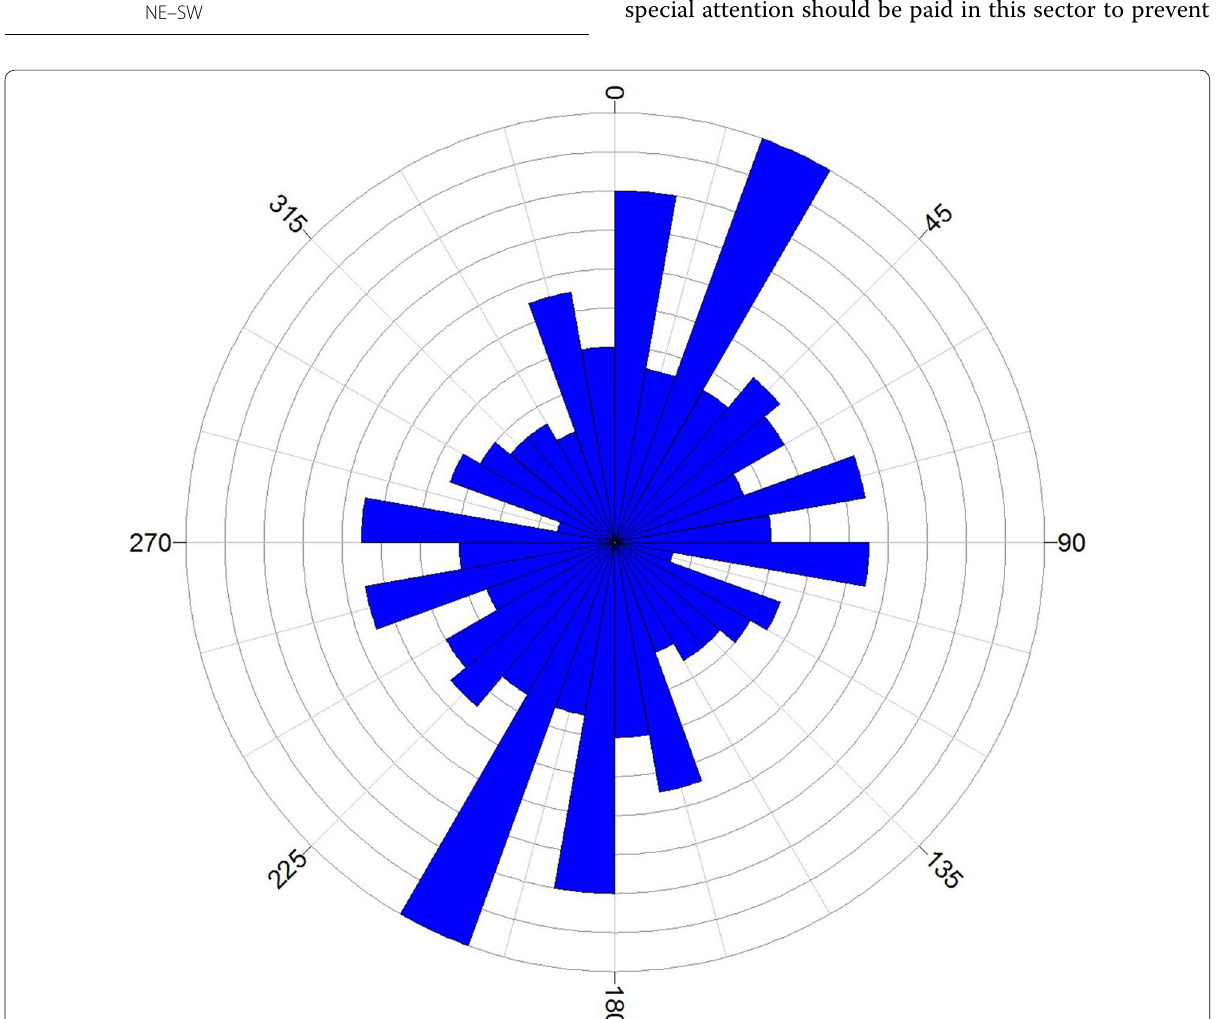
Fig. 11 Rose diagram of lineaments revealed by this